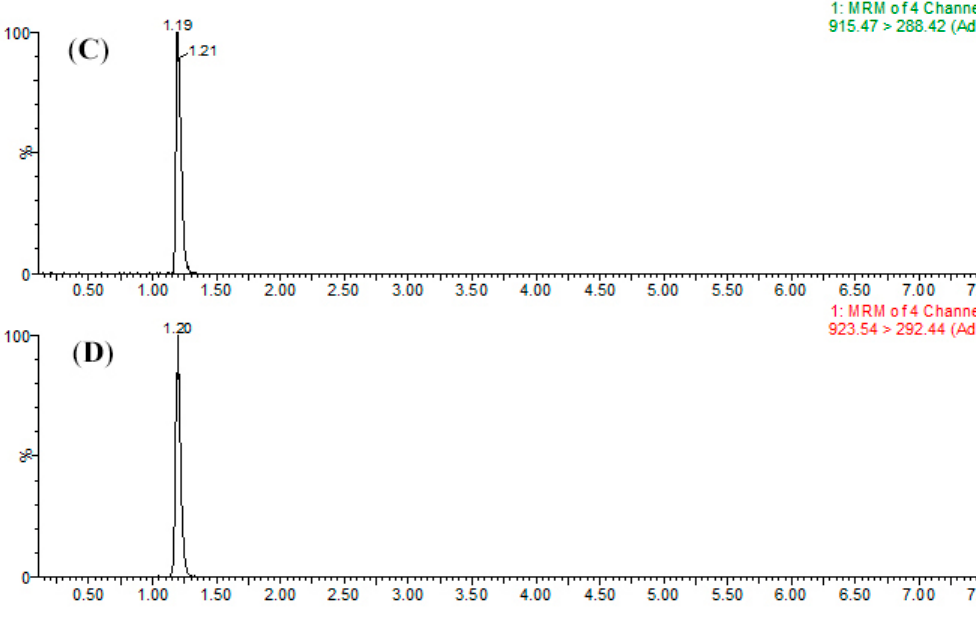
Figure 5. MRM chromatograms of ( A ) SPA1-H (1 µ g mL − 1 ) and ( B ) SPA1-D (500 ng mL − 1 ) for the mixture of peptide standards and ( C ) SPA1-H (479.3 ng mL − 1 ) and ( D ) SPA1-D (500 ng mL − 1 ) for kiwifruit raw extract samples.